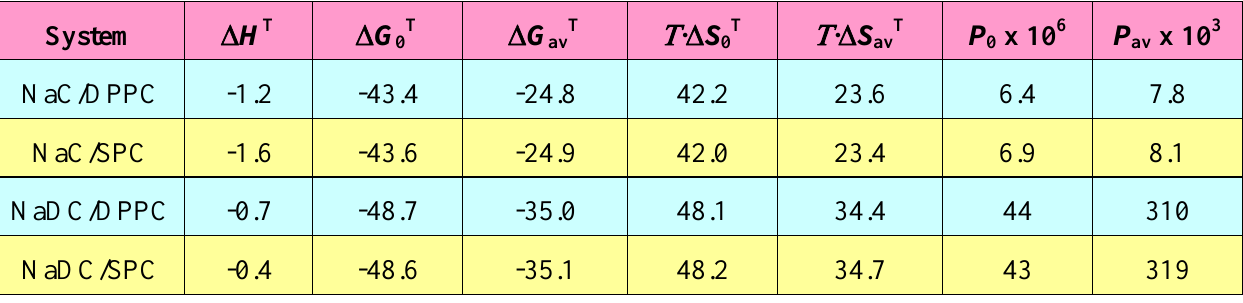
Table 2. Thermodynamic parameters for the partitioning of NaC and NaDC into DPPC and SPC membranes dispersed in water at pH 7.5 at 60 °C (liquid crystalline phase). The thermodynamic values are given in kJ·mol -1 [56,